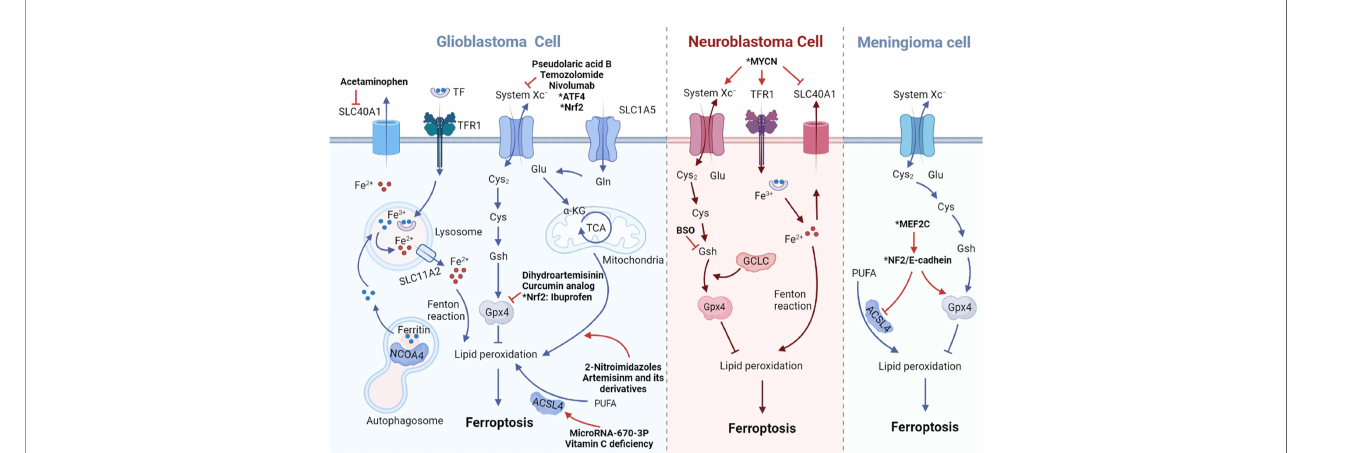
FIGURE 1 | Impacts of ferroptosis-related transport proteins in three malignant brain tumor cells. In GBM cell, iron transport-related proteins DMT1 (SLC11A2), Fpn1 (SLC40A1), TFR1 and amino acid transporters system Xc – (SLC7A11/SLC3A2), ASCT2 (SLC1A5) regulate the occurrence of ferroptosis all together. In MYCN- ampli fi ed neuroblastoma cell, lipid peroxidation and cell death are promoted due to increased expression of TFR1 and System Xc – and lower expression of Fpn1. In meningioma cell, MEF2C mediated upregulation of NF2 and E-cadherin inhibits Erastin-induced ferroptosis. Arrows indicate promotion and blunt-ended lines indicate inhibition. Cys, cysteine; Cys2, cystine; GSH, glutathione; GPX4, glutathione peroxidase 4; Glu, glutamate; Gln, glutamine; TF, transferrin; TFR1, transferrin receptor 1; PUFA, polyunsaturated fatty acid; ACSL4, acyl-CoA synthetase long-chain family member 4; TCA, tricarboxylic acid cycle; a -KG, a -ketoglutarate; NCOA4, nuclear receptor coactivator 4; ATF4,activating transcription factor 4; Nrf2, nuclear factor erythroid-2-related factor; MYCN, BHLH Transcription Factor; MEF2C, Myocyte Enhancer Factor 2C; NF2, neuro fi bromatosis type 2; BSO, buthionine